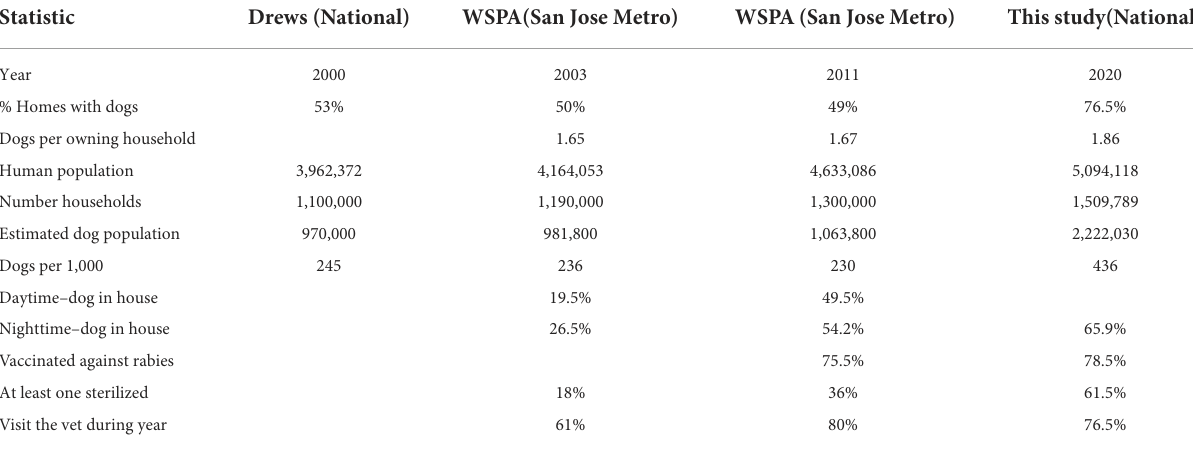
TABLE 6 Four dog surveys in Costa Rica in present